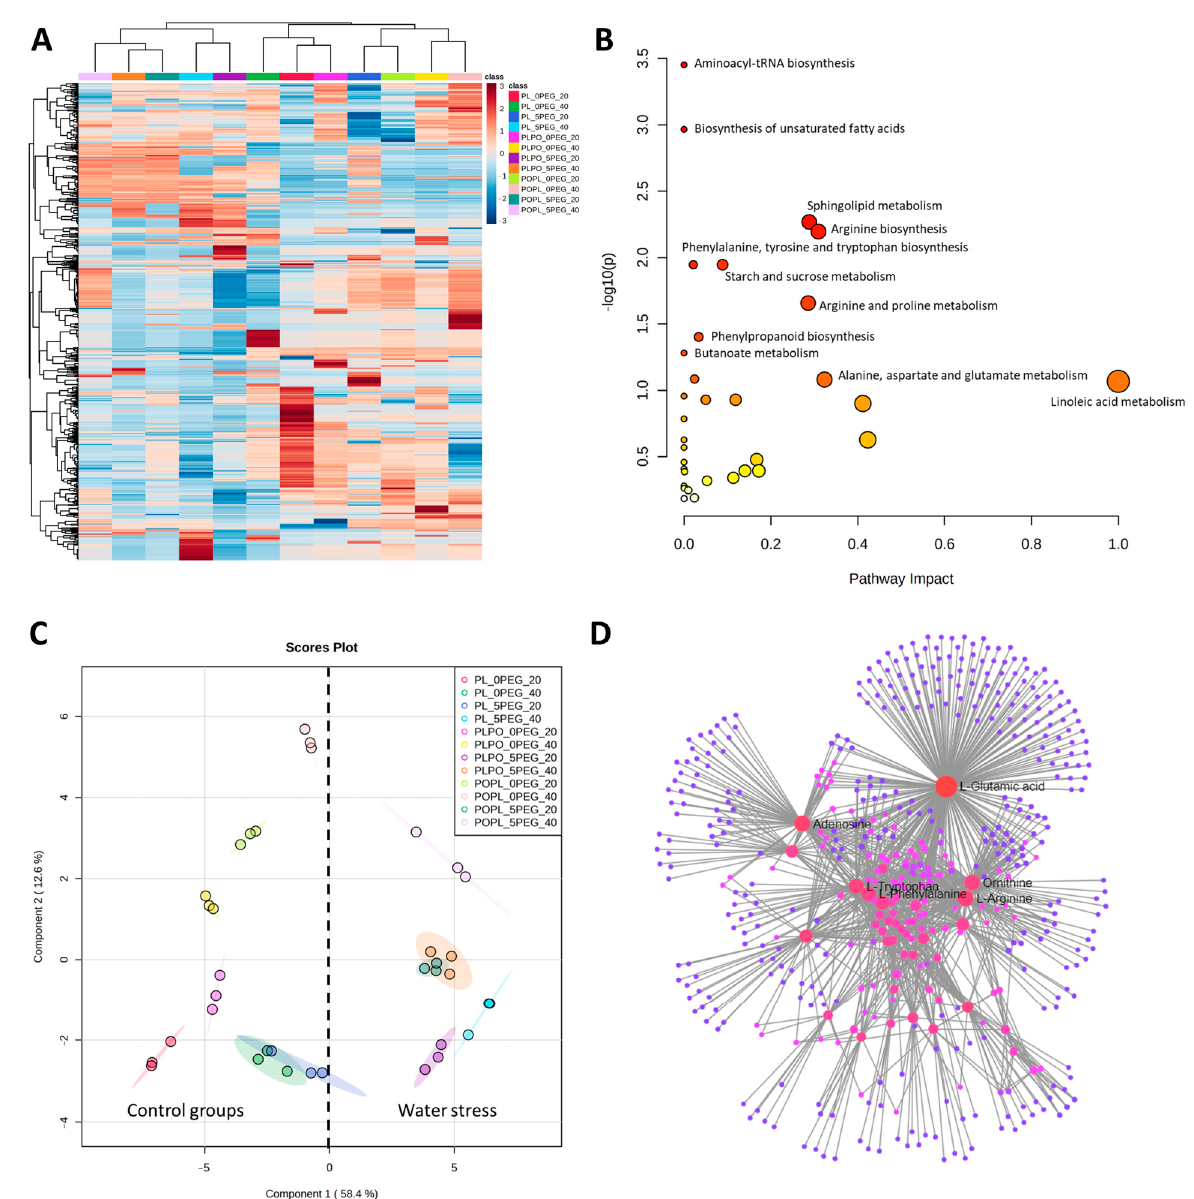
Figure 4. Metabolomics of Vanilla plants with and without water stress. ( A ) Hierarchical ordering heatmap, ( B ) pathway analysis, ( C ) principal component analysis (PCA), and ( D ) network analysis of metabolomic data obtained by UPLC-MS-QTOF from vanilla seedlings exposed to 20 and 40 days of PEG-induced water stress. The heatmap was generated using Pearson and Ward for distance measure and clustering algorithm, respectively. The pathway analysis was determined by Mummichog algorithm, KEGG database, and Oryza sativa library. PL: Vanilla planifolia , PLPO: V. planifolia × V. pompona , POPL: V. pompona × V. planifolia , 0 PEG: control group ( − 0.08 mPa), 5 PEG: hydric stress ( − 0.49 mPa), 20: 20 days of water stress exposure, and 40: 40 days of water stress exposure.